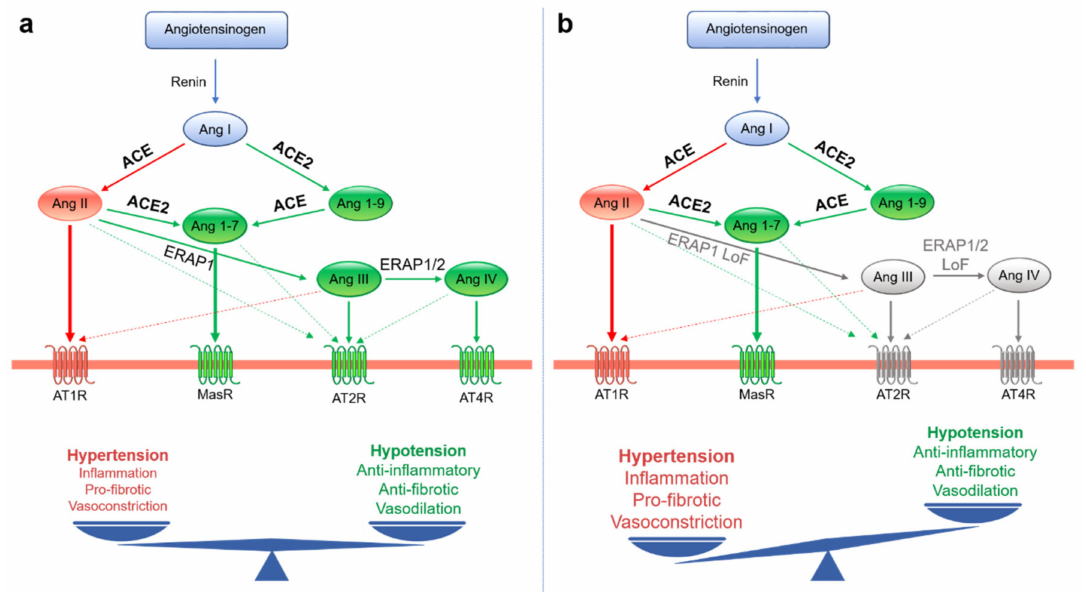
Figure 2. Schematic illustration of the renin-angiotensin system (RAS) showing the dual ACE- and ACE2-dependent pathways in the presence of functional ( a ) or dysfunctional ( b ) ERAP1 and ERAP2 enzymes. ( a ) In the classical ACE/Ang II/AT1R axis (red lines), Ang II binds its AT1R receptor, causing hypertension, inflammation, vasoconstriction, and fibrosis. The ACE2/Ang-(1-7)/MasR axis (green lines) counterbalances the harmful effects of the ACE/Ang II/AT1R axis. The cleav- age of Ang substrates by ERAP1 and ERAP2 activities (green lines) is also shown. ( b ) Loss-of-function variants of ERAP aminopeptidases impair Ang III and Ang IV production, thus contributing to the increase of circulating Ang II levels and the resulting hypertension. Ang: angiotensin, ACE: angiotensin-converting enzyme, AT1R: angiotensin type-1 receptor, AT2R: angiotensin type-2 receptor, AT4R: angiotensin type-4 receptor, MasR: Mas